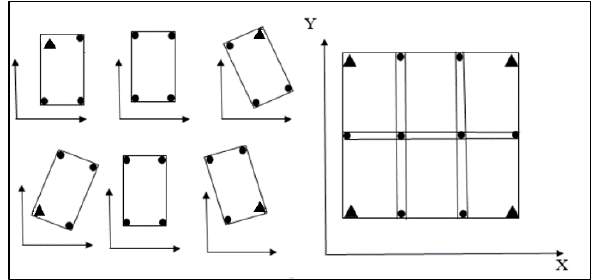
Figure 4. Simultaneous adjustment of sections bloc.